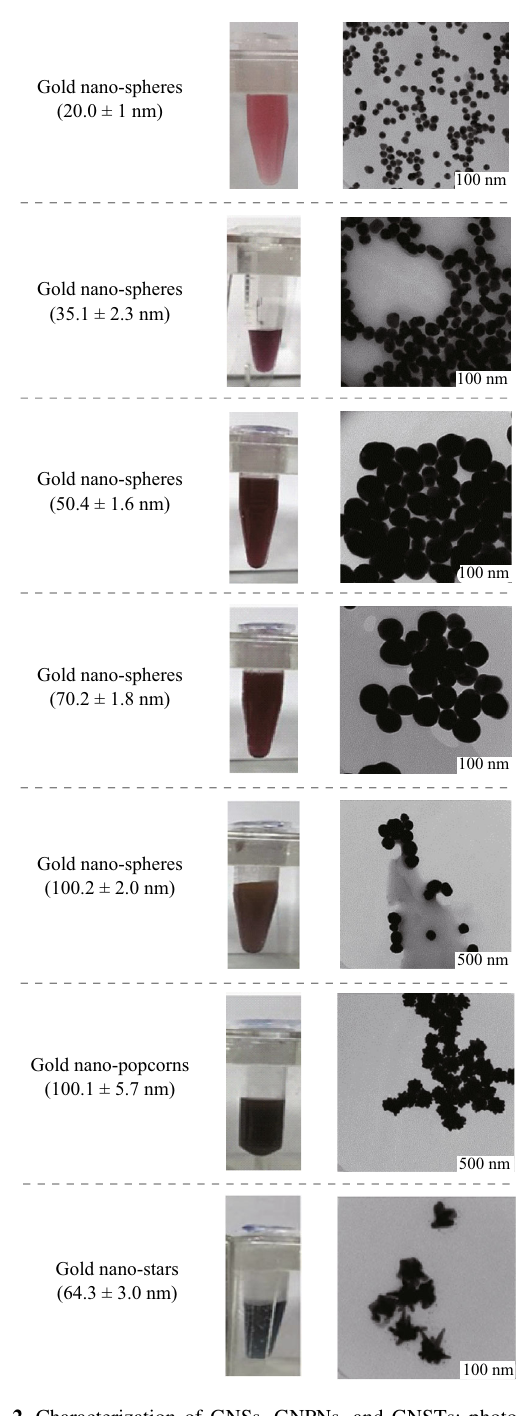
Fig. 2 Characterization of GNSs, GNPNs, and GNSTs: photograph of colloidal solutions and TEM images of gold